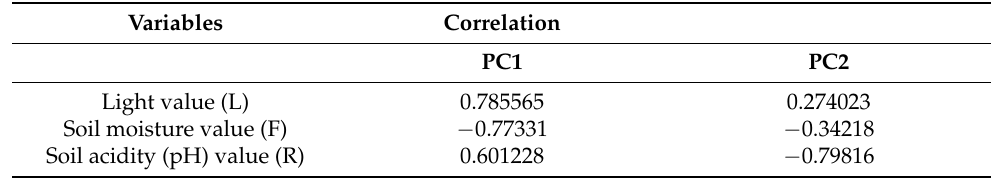
Table 2. Factor coordinates of the variables.